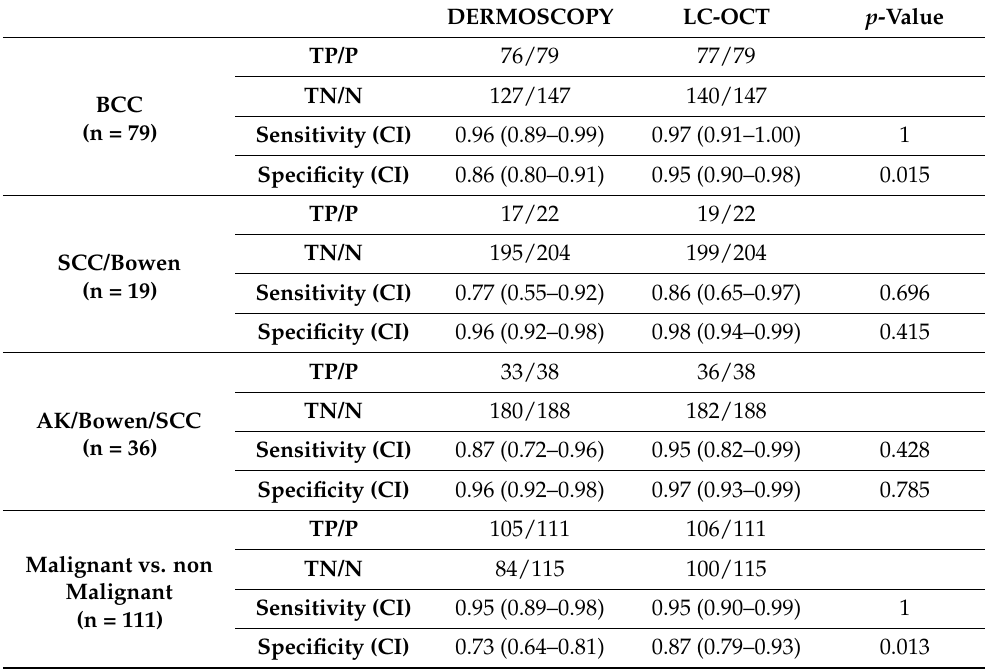
Table 2. Sensitivity and specificity of dermoscopy and LC-OCT considering only histologically confirmed